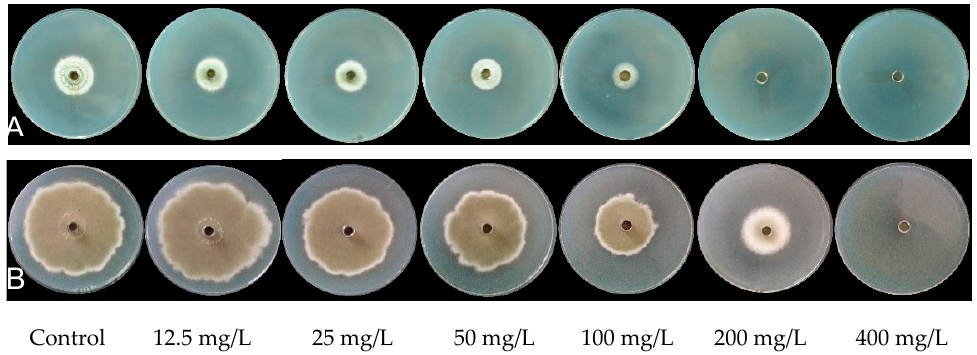
Figure 2. The minimum inhibitory concentration (MIC) and minimum fungicidal concentration (MFC) of PiCB against P. digitatum at second day ( A ) and sixth day ( B ) of inoculation.